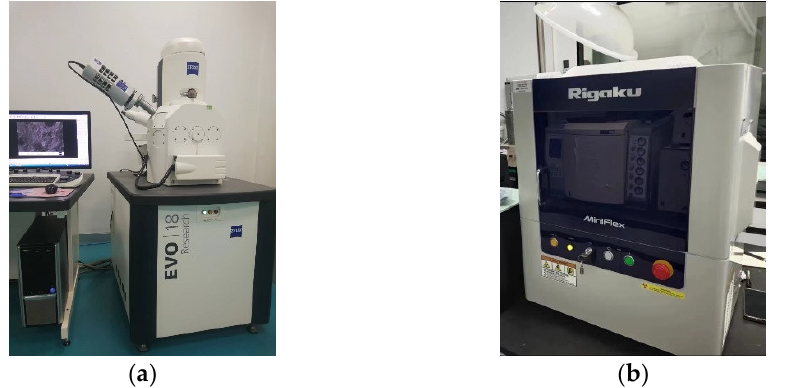
Figure 7. ( a ) Low vacuum scanning electron microscope equipment and ( b ) X-ray diffraction instru- ment.